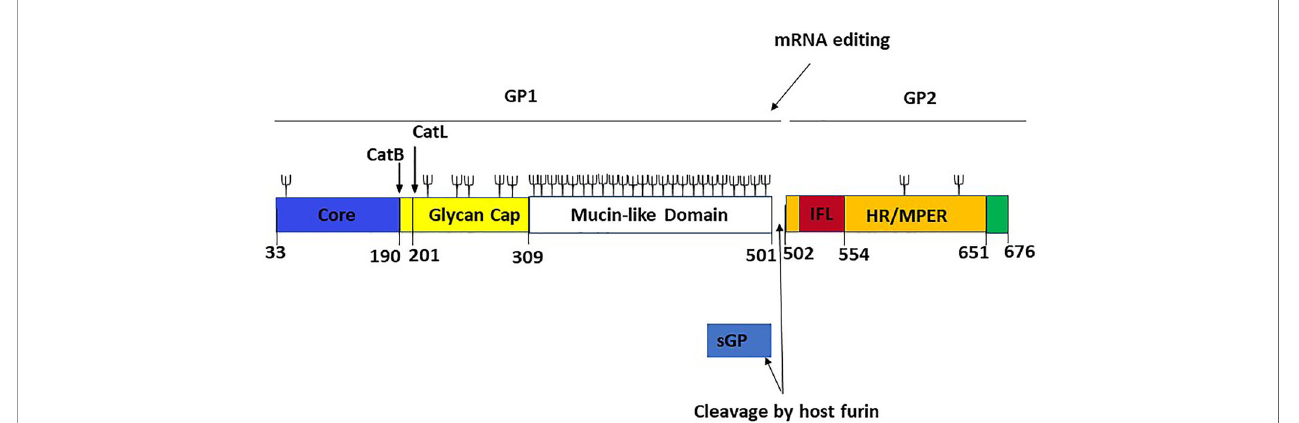
FIGURE 6 | Linear schematic representation of the Ebola virus GP monomer with GP1,2 subunits and sGP [adapted from ref (21)]. The GP1 core (blue, residues 33 – 189), the cathepsin cleavage loop (yellow, residues 190 – 210), the glycan cap (yellow, residues 211 – 308), and the highly glycosylated mucin-like domain (white, residues 309 – 501) are the four parts of GP1. An internal fusion loop (IFL) region (red, residues 502 – 553), an hepta repeat (HR)/membrane-proximal external region (MPER) (orange, residues 554 – 650), and a transmembrane domain/cytoplasmic tail region (green residues 651 – 676) constitute GP2. The co-transcriptional editing of the GP gene-editing site, which results in the transcript of the sGP product and the post-transcriptional cleavage of the GP precursor by a host furin, are also shown. The proteolytic cleavages of cathepsin B (CatB) and cathepsin L (CatL) are also depicted. Cathepsin B cleaves at position 190, while cathepsin L cleaves at position 201. Branched lines indicate the approximate positions of potential glycosylation